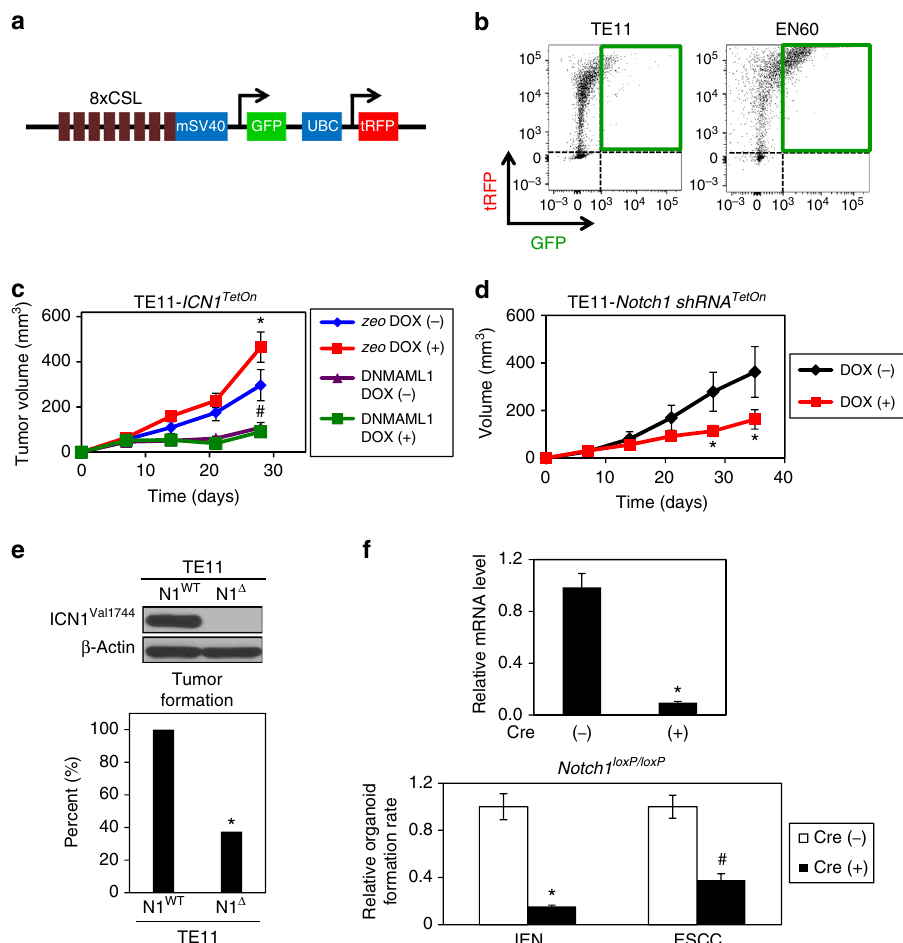
Fig. 2 Notch1 promotes ESCC tumorigenesis. a Schematic of 8 × CSL-GFP reporter. Notch activation permits GFP reporter expression via concatemeric